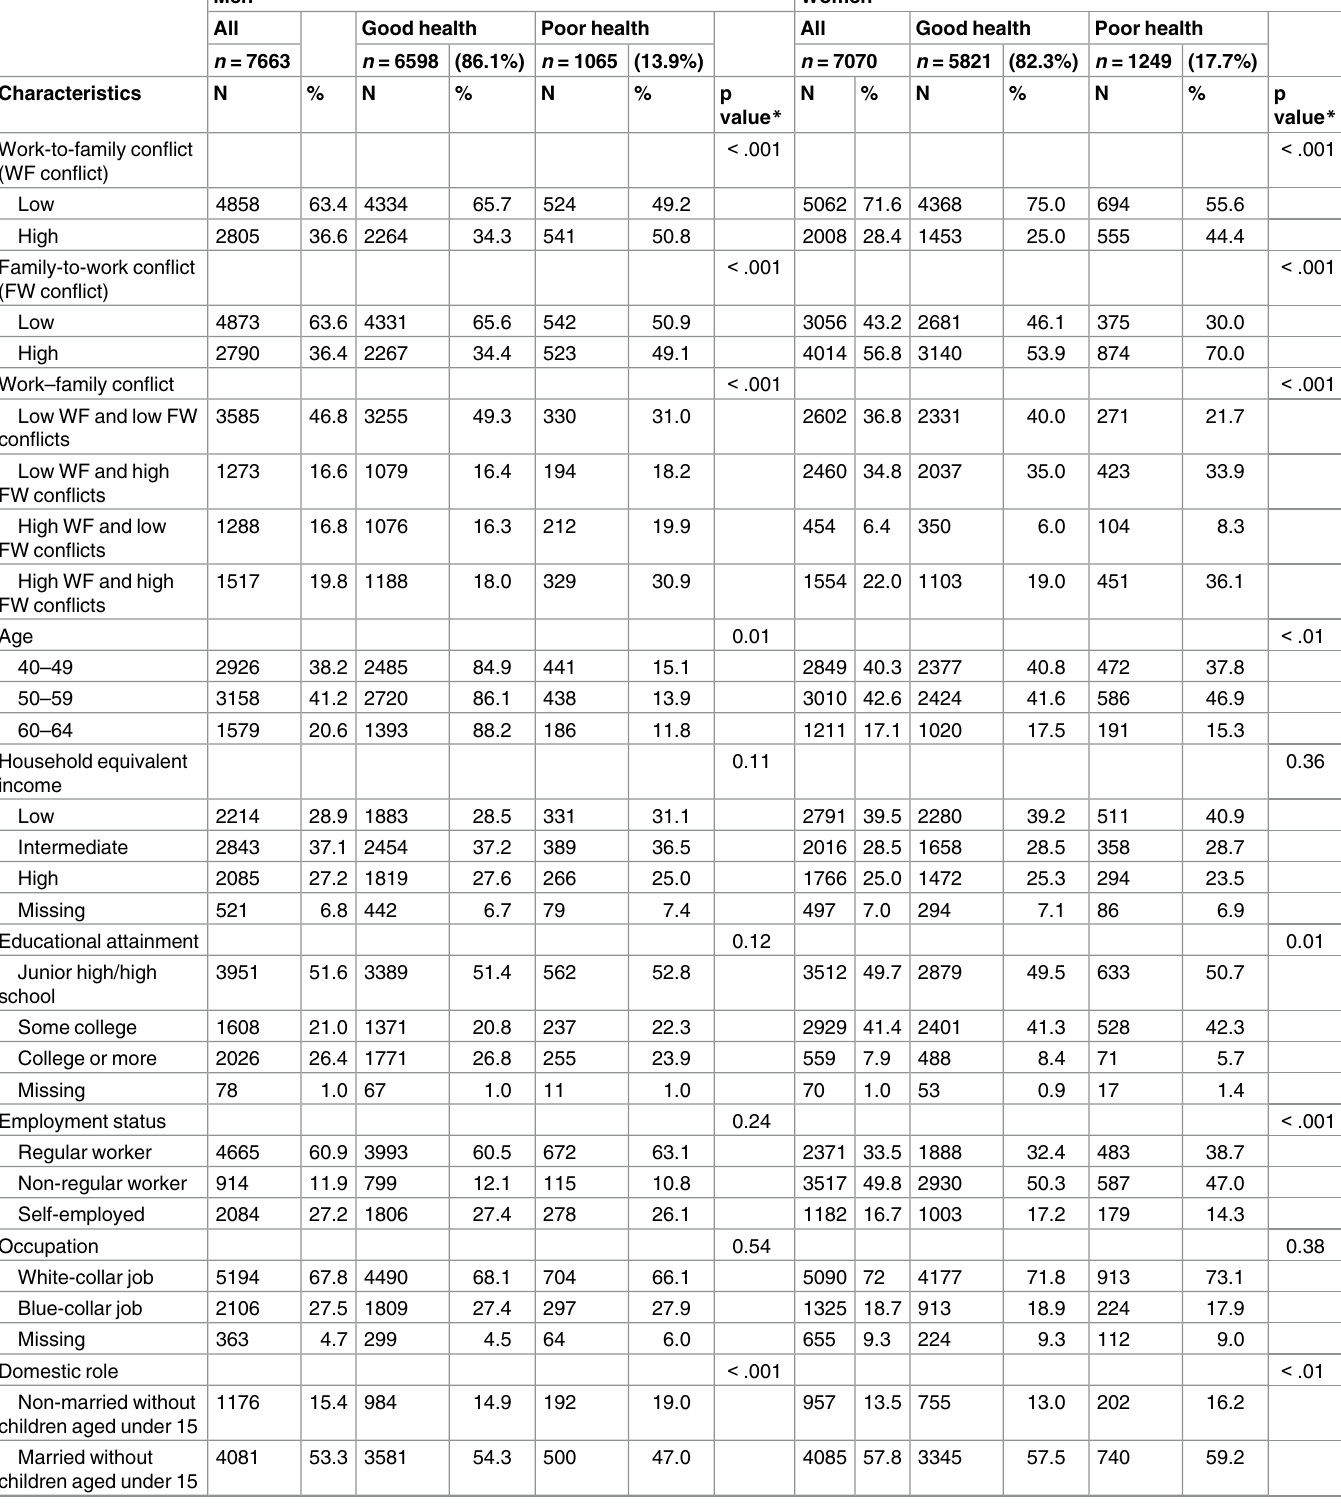
Table 1. Sex specific work-family conflict and demographic characteristics according to self-rated health. Men Women All Good health Poor health All Good health Poor